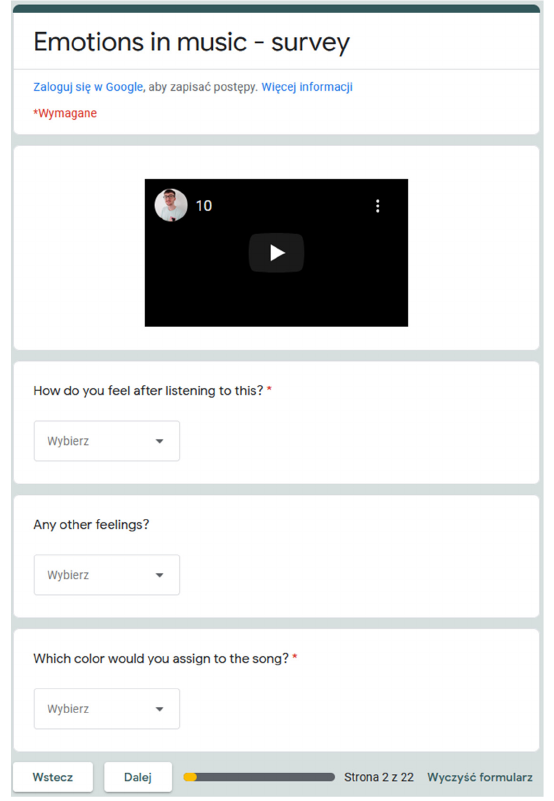
Figure 6. Questions with regard to the piece of film music the person is listening to. There is also a possibility to clear the form (description in